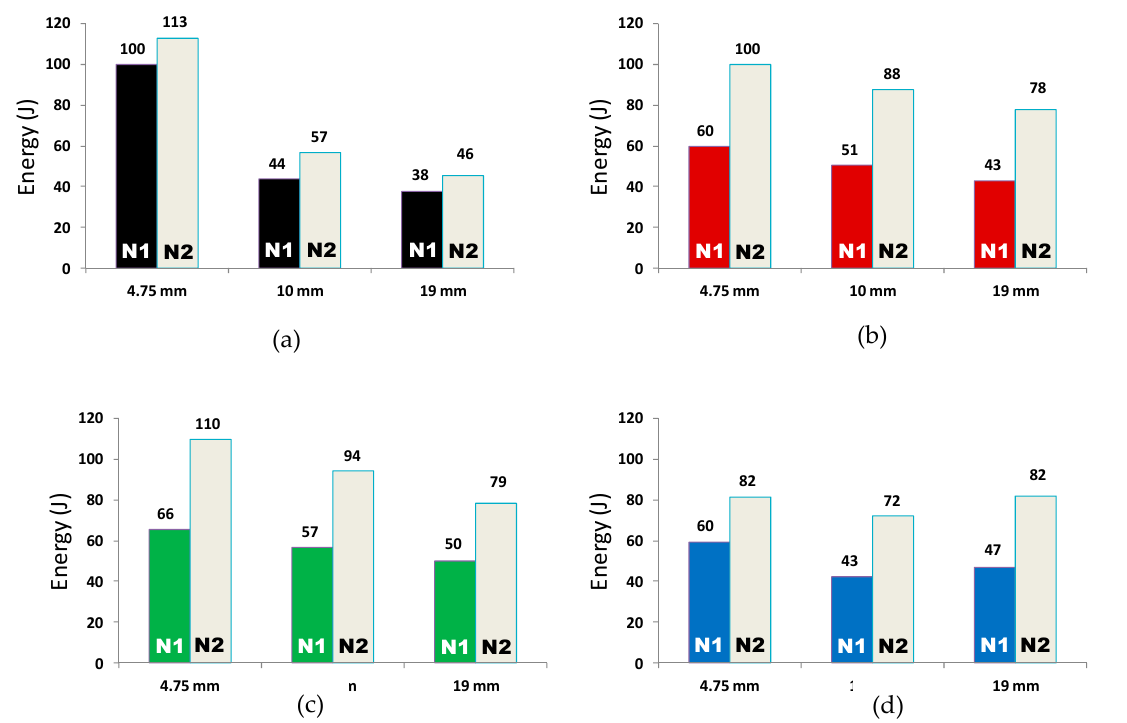
Figure 16. Results of drop weight test on U-shape specimens ( a ) control specimens, ( b ) with (F) 0.5% fibers, ( c ) with (F-4S) 0.5% fibers and 4% SBR, ( d ) with (F-8S) 0.5% fibers and 8% SBR.